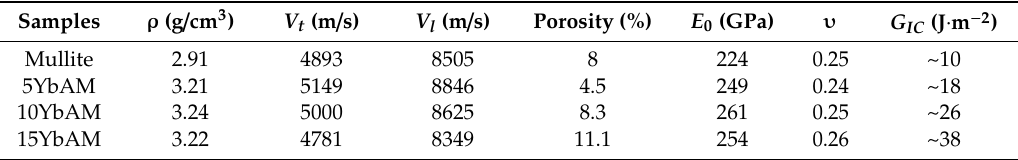
Table 2. The density and mechanical properties of the samples.